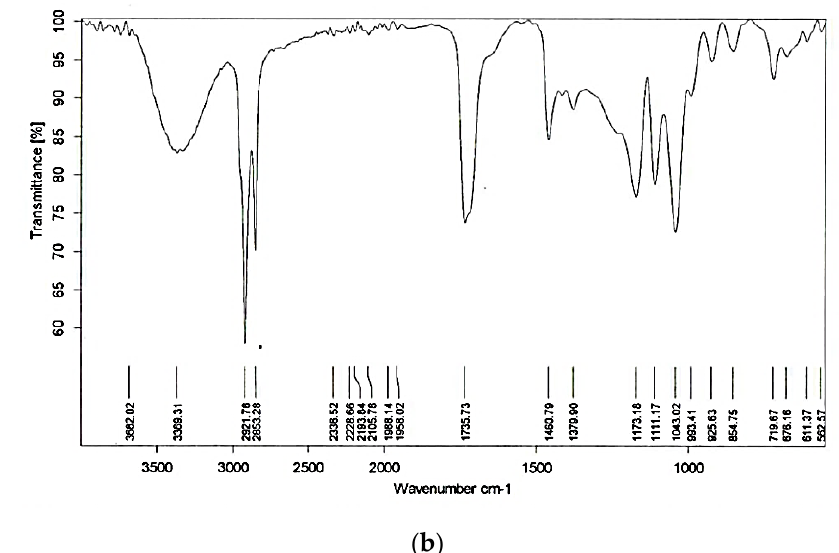
Figure 2. ( a ) FTIR spectra of PKOo-PKS blend at a ratio of 40:60 w/w , and ( b ) FTIR spectra of purified monolaurin from glycerolysis product.